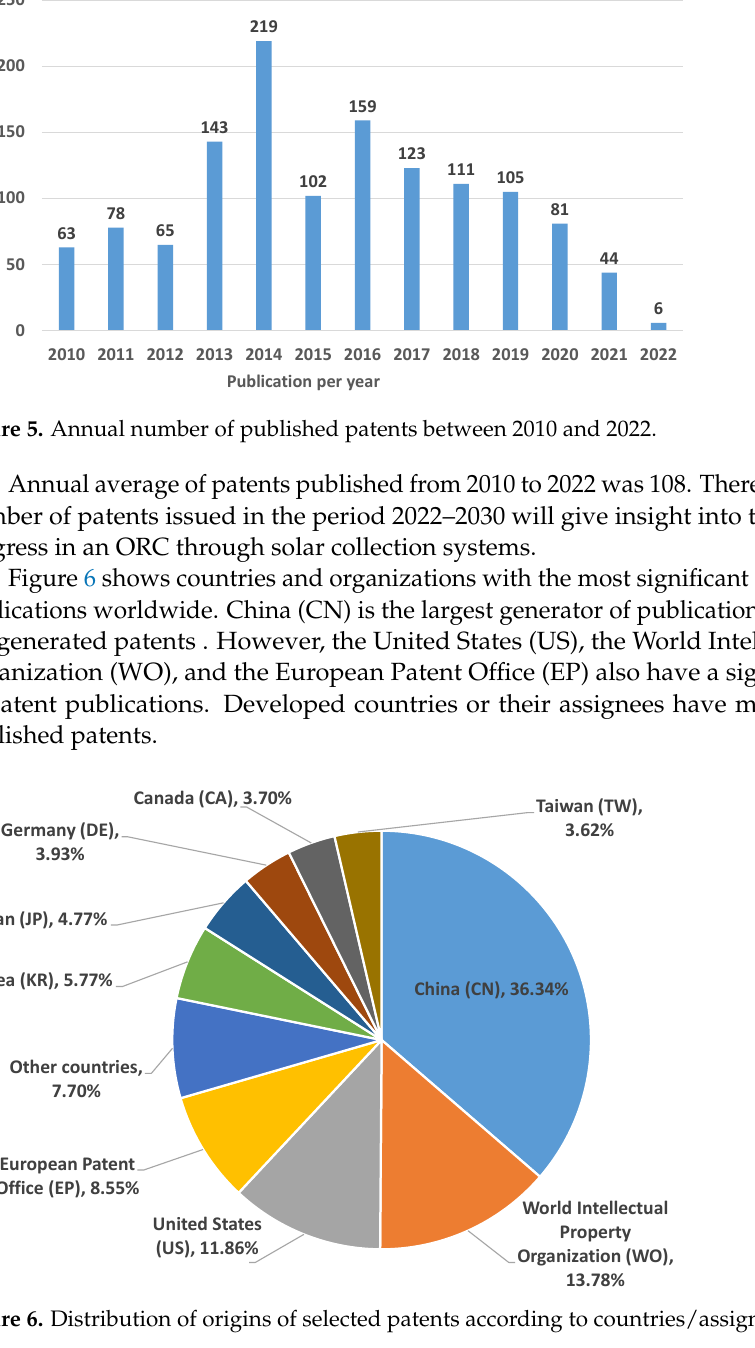
Figure 6. Distribution of origins of selected patents according to countries/assignees. Of the countries in the Americas, excluding the English-speaking countries, only Brazil and Mexico have patent publications; 31 and 6, respectively. Central America and part of South America have good solar radiation values to implement ORC plants that incorporate solar collection systems